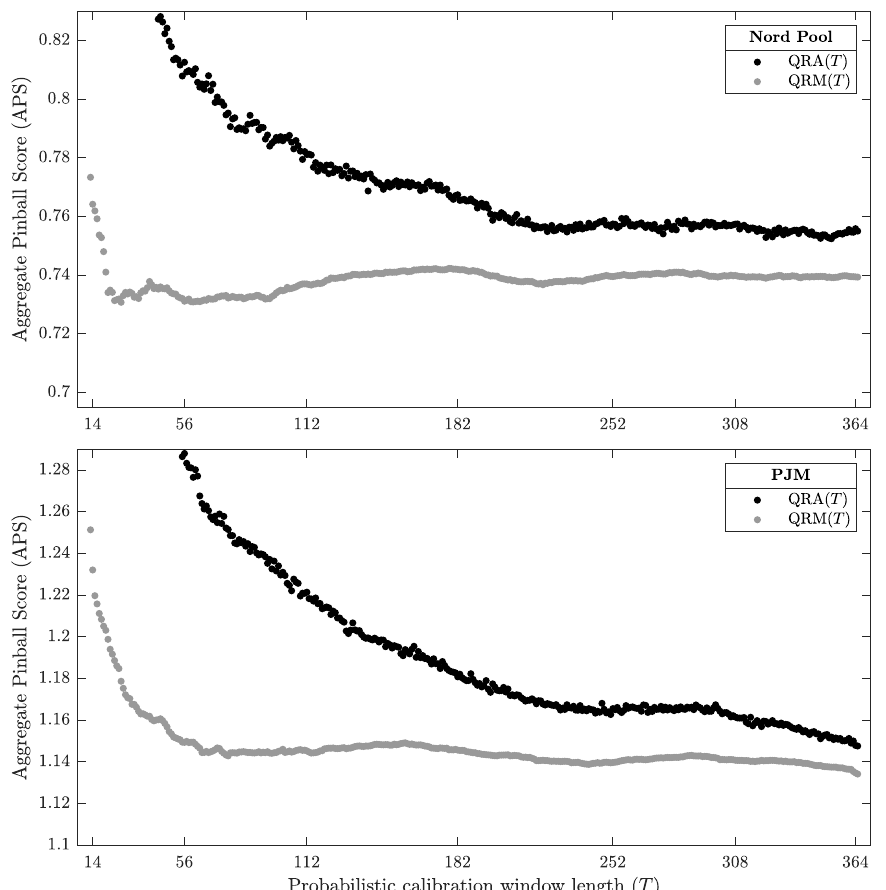
Figure 4. Aggregate Pinball Scores (APS) for the Nord Pool ( top ) and PJM ( bottom ) datasets as a function of T = 14,15, . . . ,364